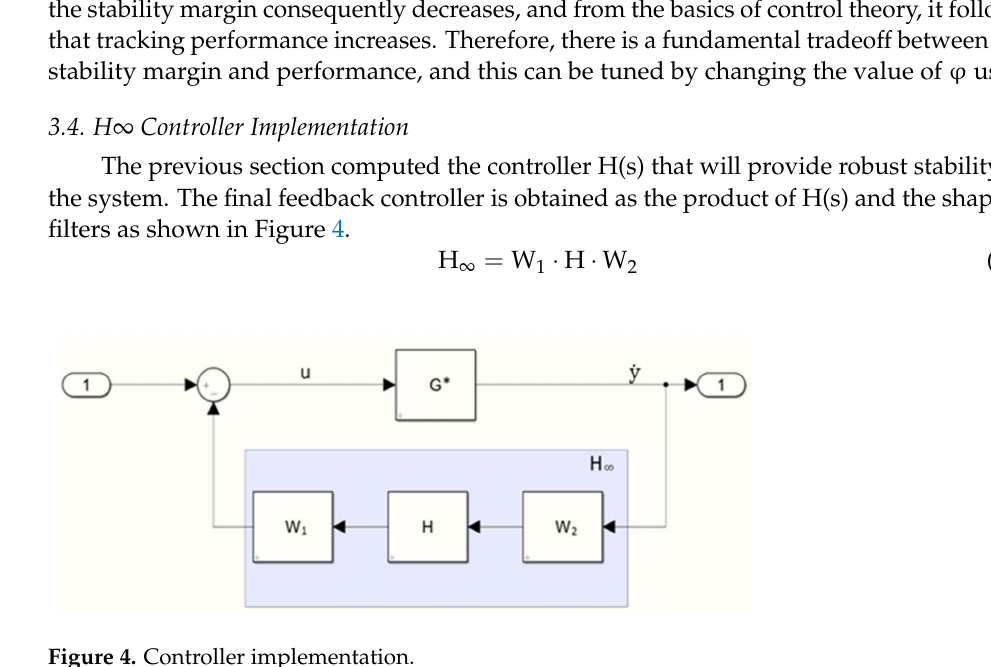
Figure 4. Controller implementation.